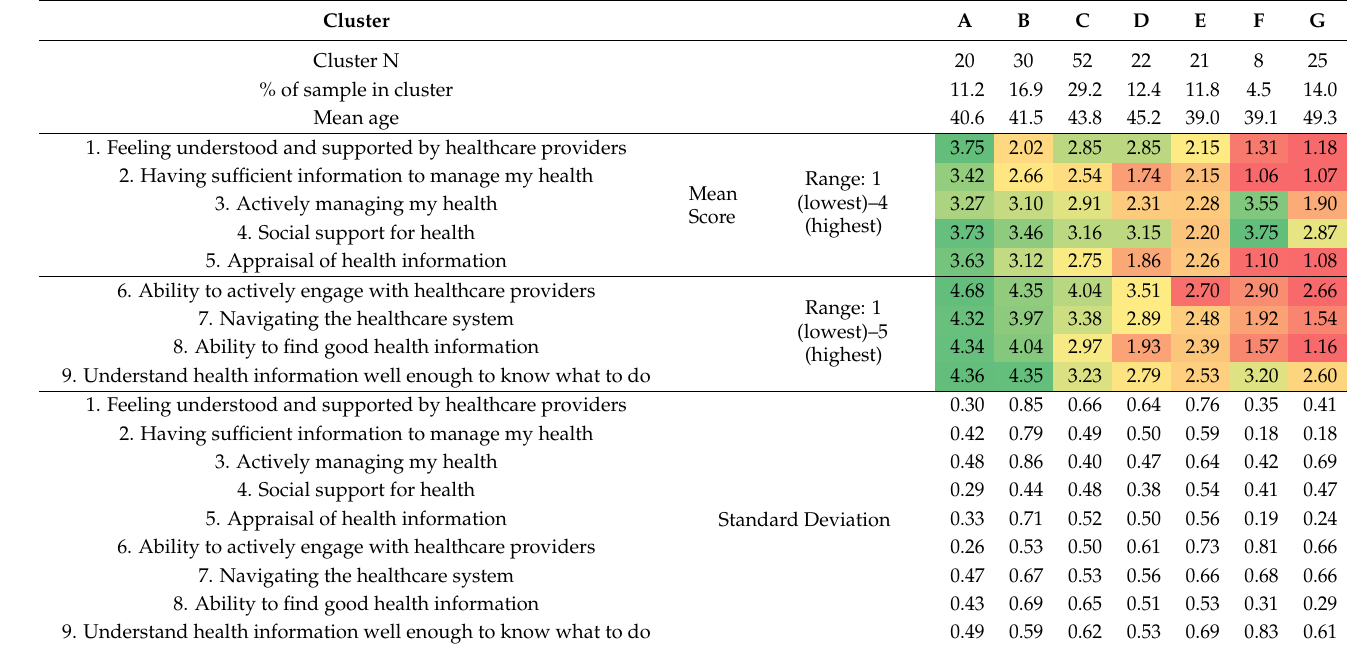
Table 2. Health literacy seven cluster solution.